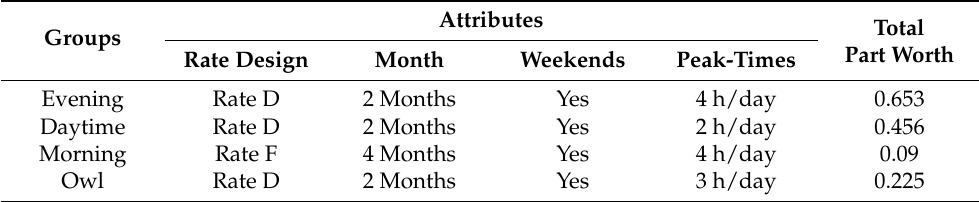
Attributes Total